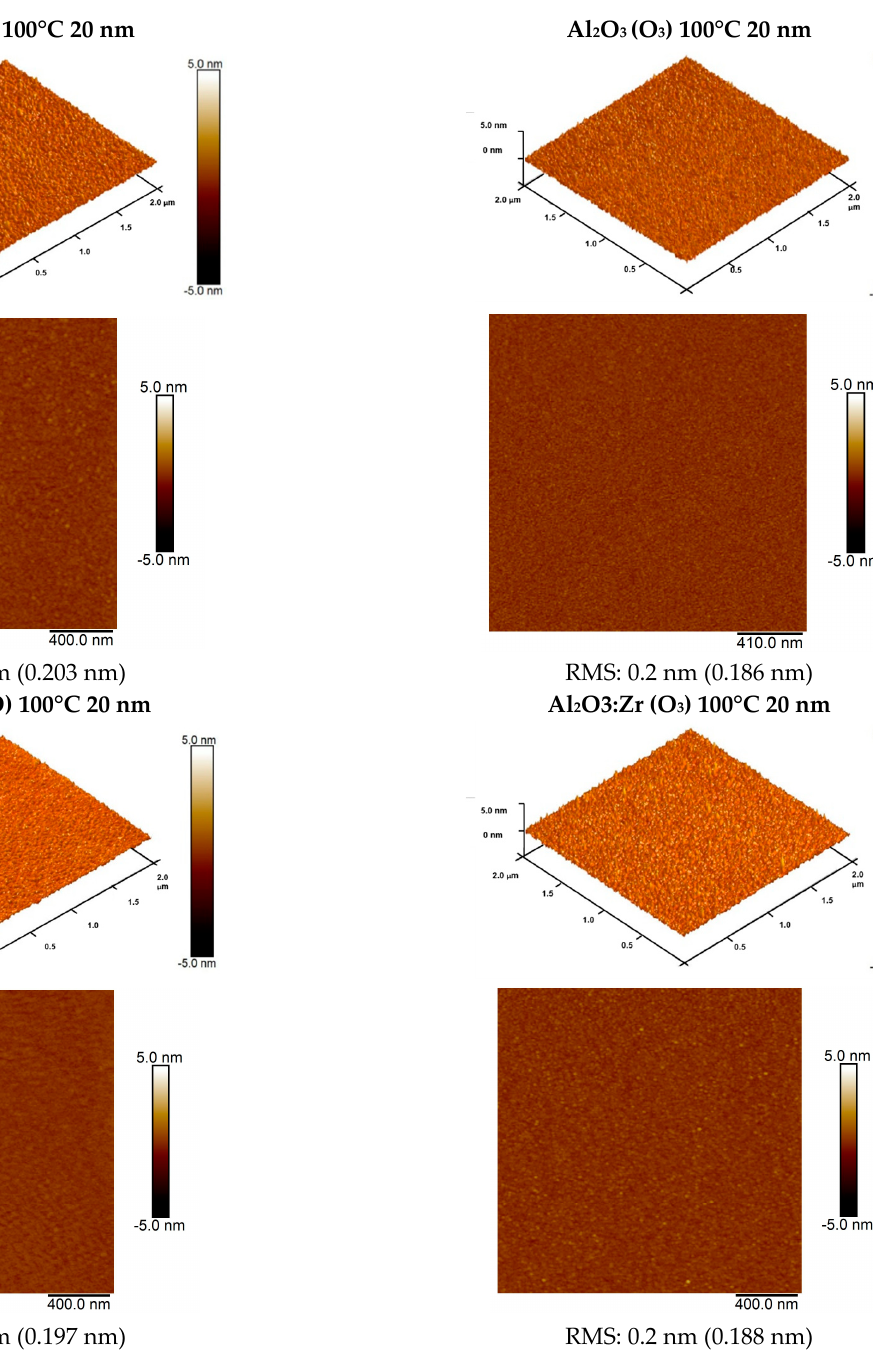
Figure 4. AFM images (2 × 2 μ m 2 ) and RMS roughness values of Al 2 O 3 and Al 2 O 3 :Zr thin films (~20 nm thick) grown with ALD from water (H 2 O) or ozone (O 3 ) at 100°C on Si substrate.